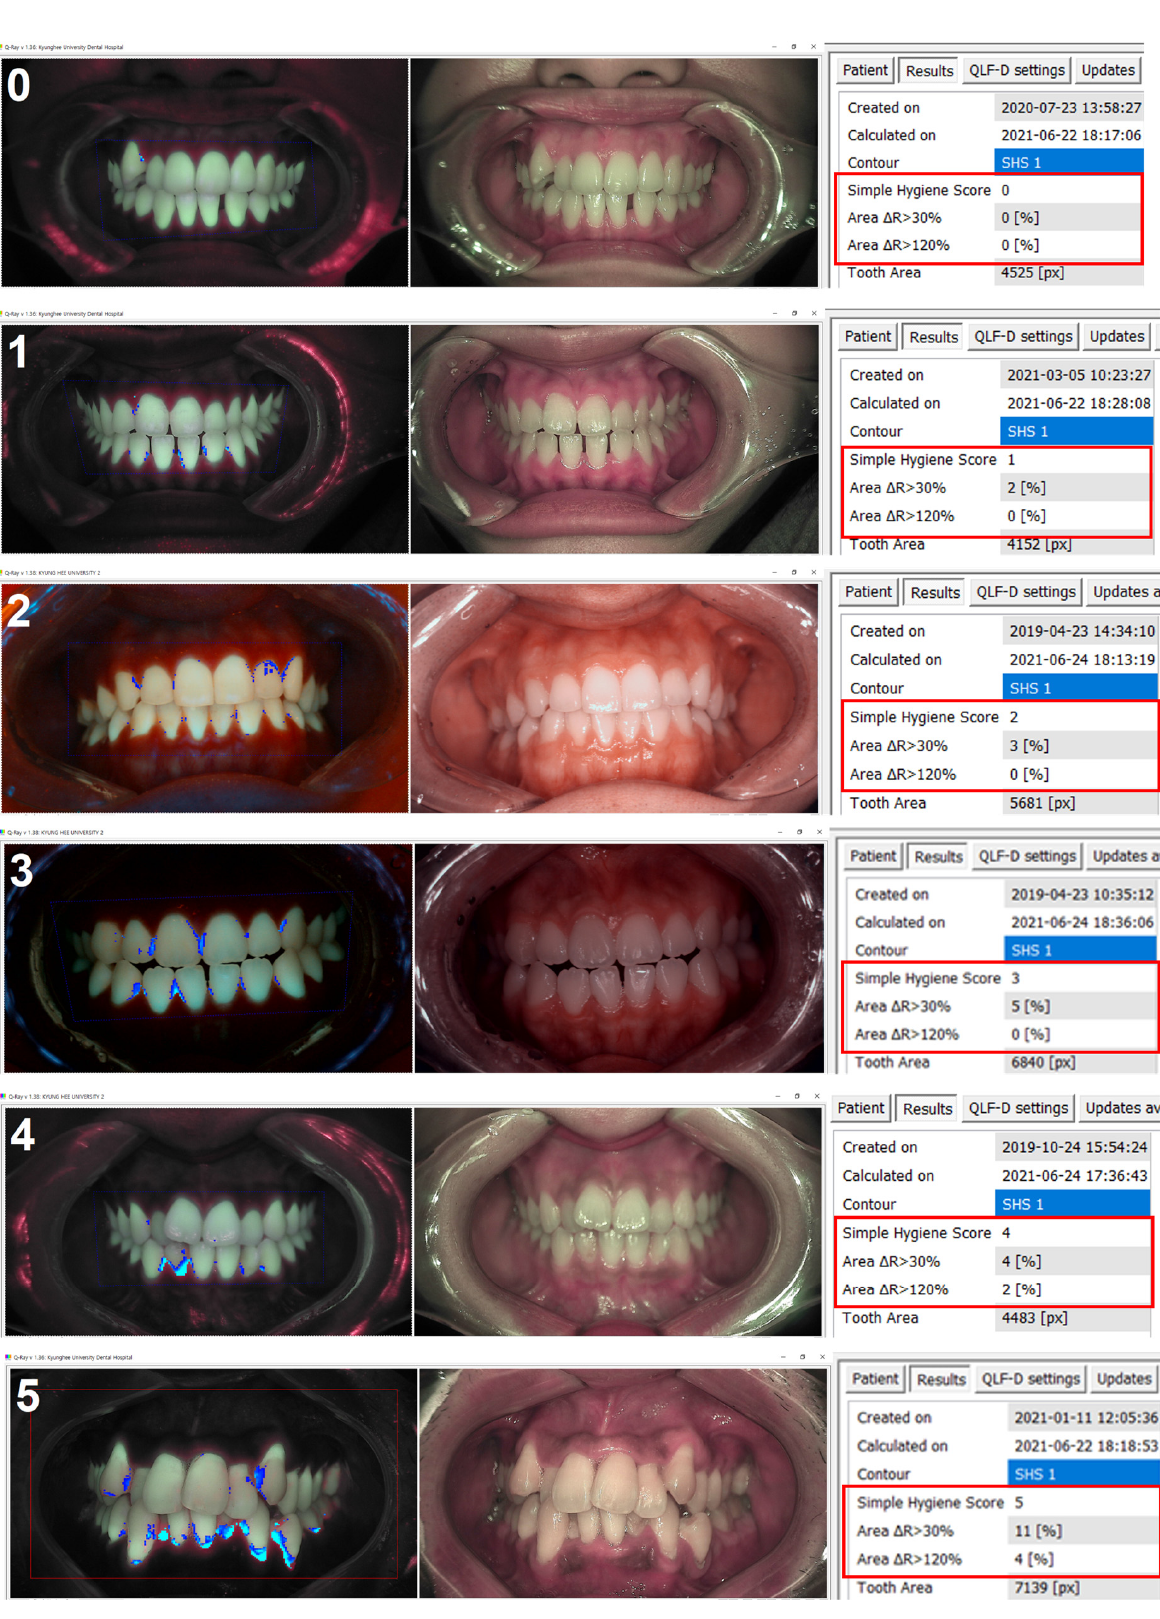
Figure 4. FPI is a score calculated by applying two variables (A 30 and A 120 ), which are regions of red fluorescent plaques corresponding to pixels with ∆ R > 30% and ∆ R > 120%, to a specific function. FPI scores were calculated in one of six categories (from 0 to